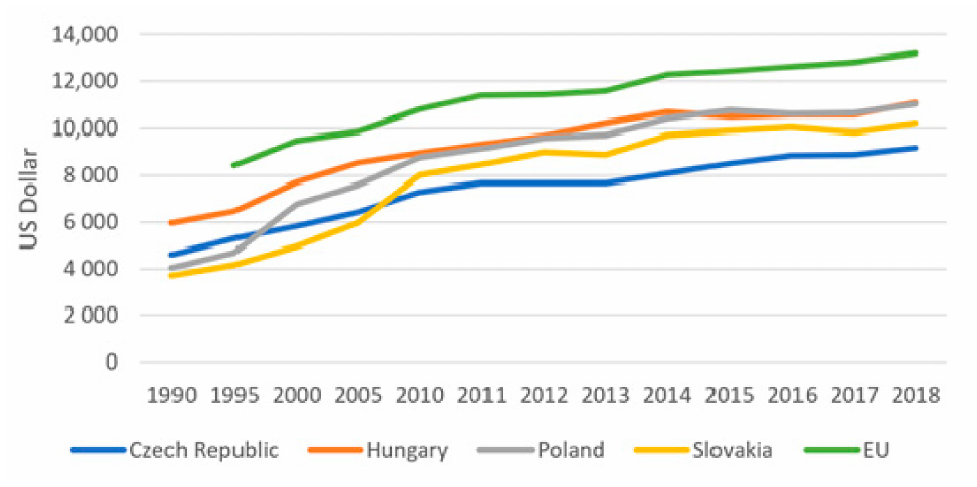
Figure 4. Energy productivity in the Visegrad Group countries in